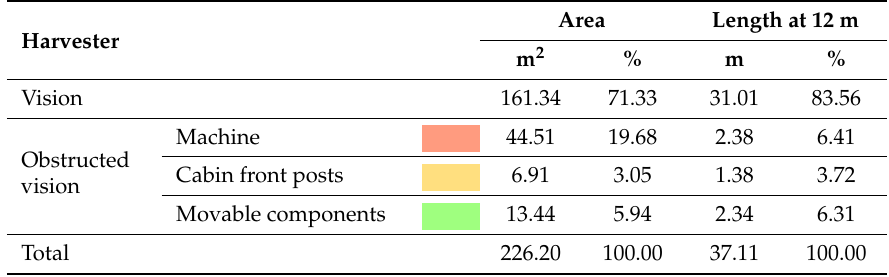
Table 2. Characteristics of the semi-circular vision to the front of harvester driver determined by the TLS method in units of area and